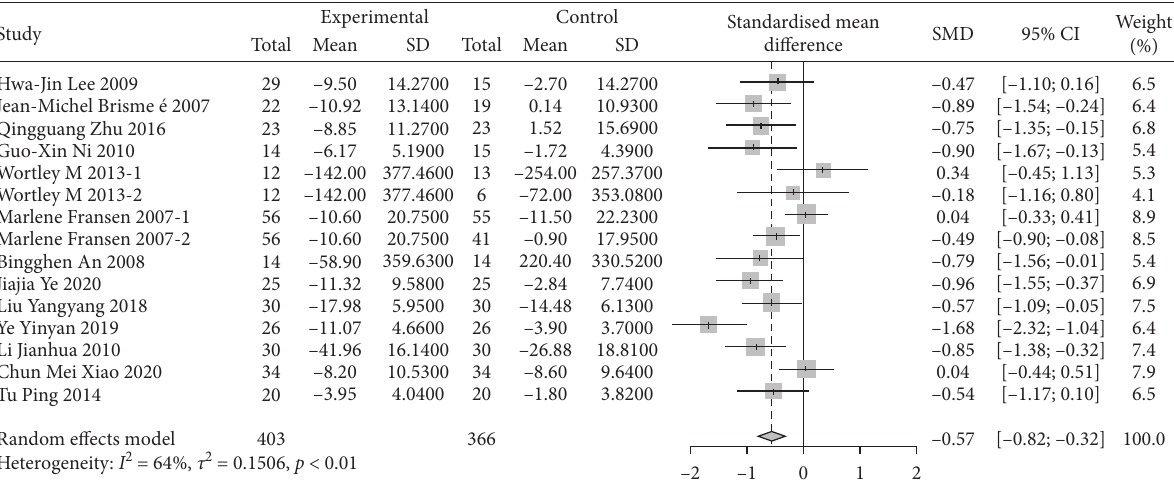
Figure 9: Meta-analysis of WOMAC physical function comparison between traditional Chinese exercise group and control